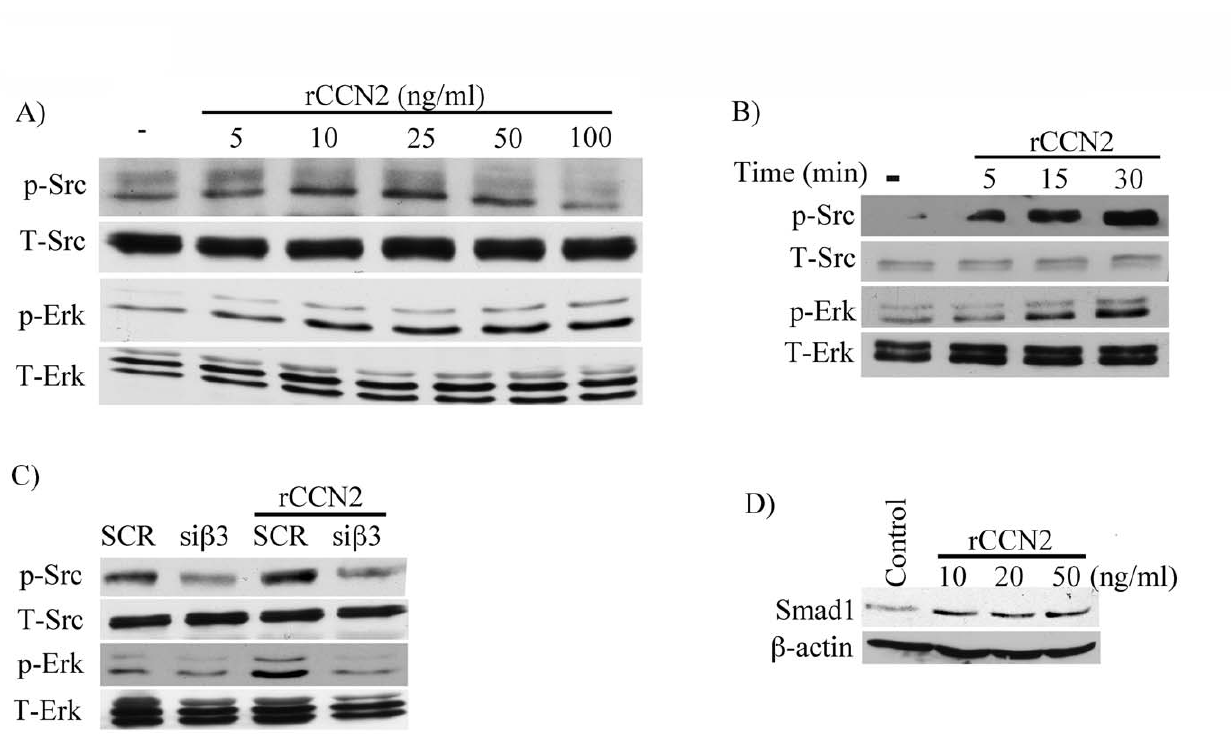
Figure 5. CCN2 induces Src and Erk1/2 phosphorylation. (A) Foreskin fibroblasts were serum starved overnight and then stimulated with indicated doses of recombinant CCN2 (rCCN2) (5 - 100 ng/ml) for 30 minutes and analyzed for Src and Erk1/2 phosphorylation. (B) Foreskin fibroblasts were serum starved overnight and then stimulated with rCCN2 (25 ng/ml) for the indicated time points and analyzed for Src and Erk1/2 phosphorylation. (C) Foreskin fibroblasts were transfected with b 3 siRNA oligos and then stimulated with rCCN2 for 30 minutes and examined the Src and Erk1/2 phosphorylation by western blot. (D) Foreskin fibroblasts were treated with rCCN2 for 48 hours and then were analyzed for Smad1 expression levels by western